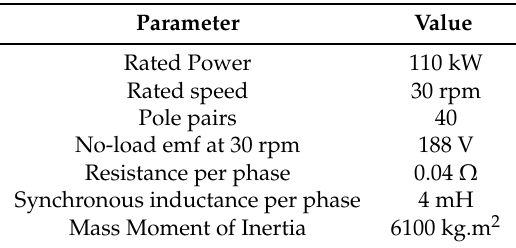
Table 5. Generator